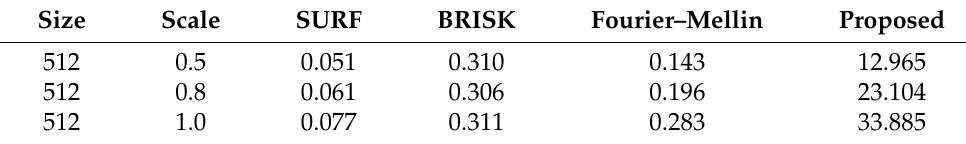
Table 4. Comparison of the execution times for rotation and scale